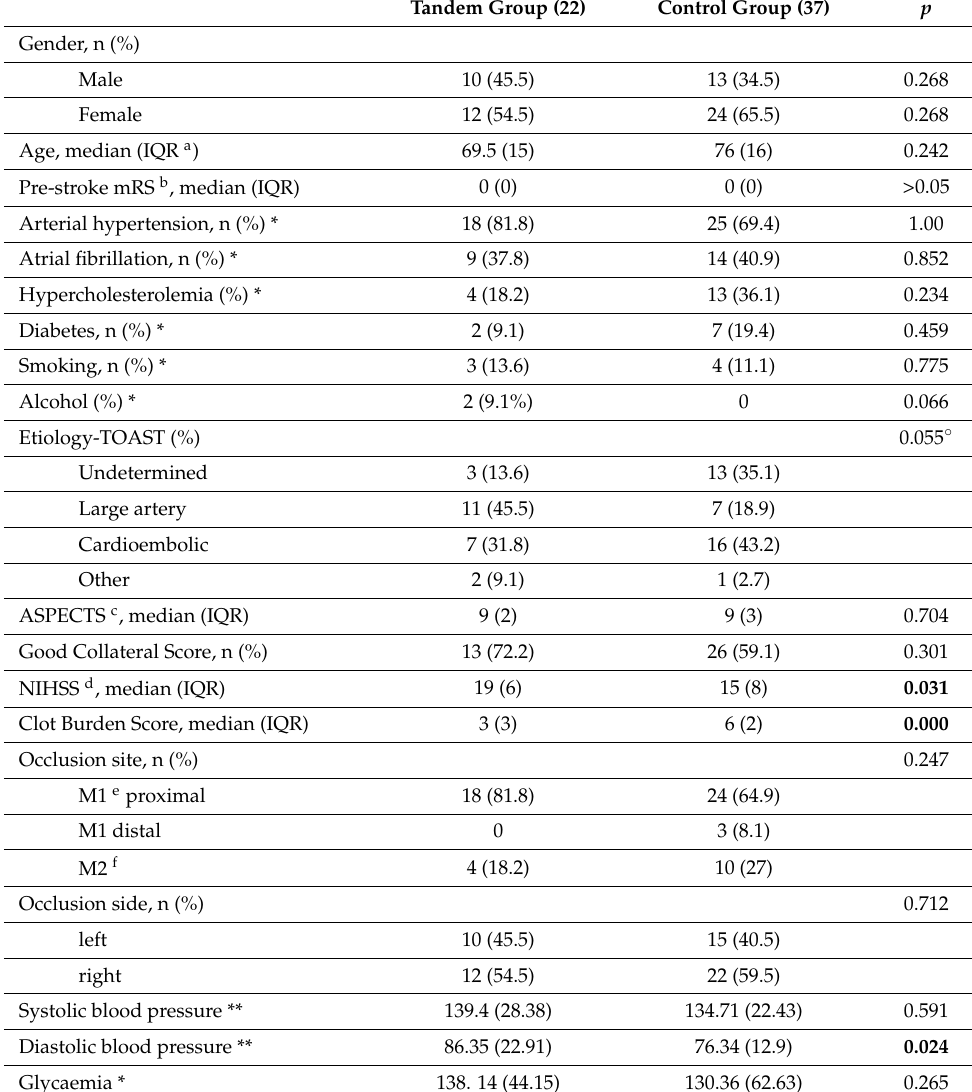
Table 1. Comparison between groups for baseline characteristics.